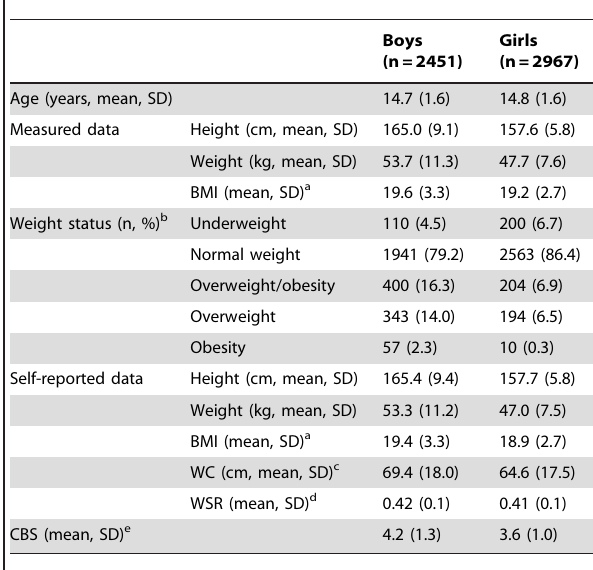
a BMI=body mass index. b weight status defined based on IOTF references and measured height and weight. c WC=waist circumference; d WSR=waist to stature ratio; e CBS=current body size.